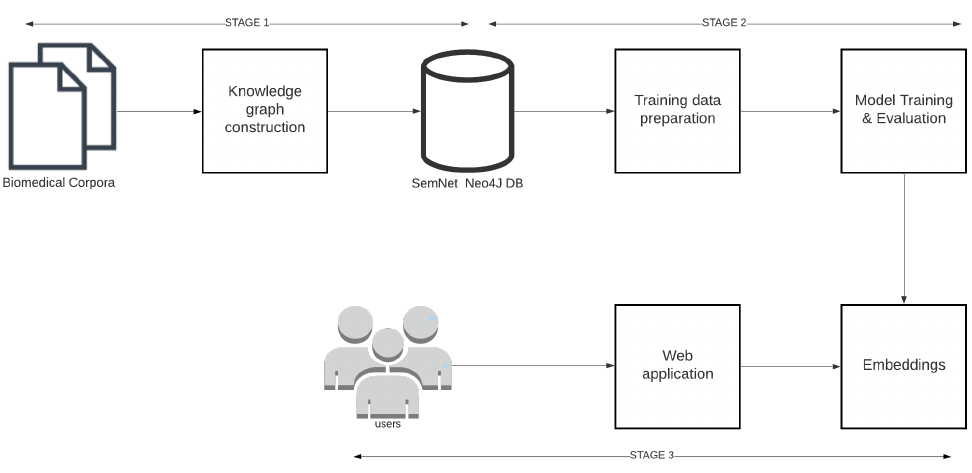
Figure 3. The link prediction pipeline and its 3 main stages: triple extraction, model training, and model